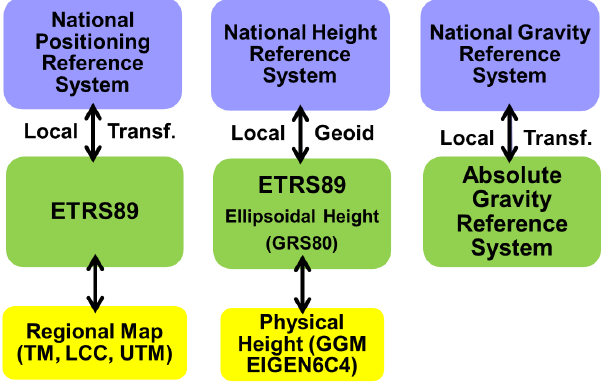
Figure 2. Transformation scheme for unification of the national po- sitioning, height and gravity reference